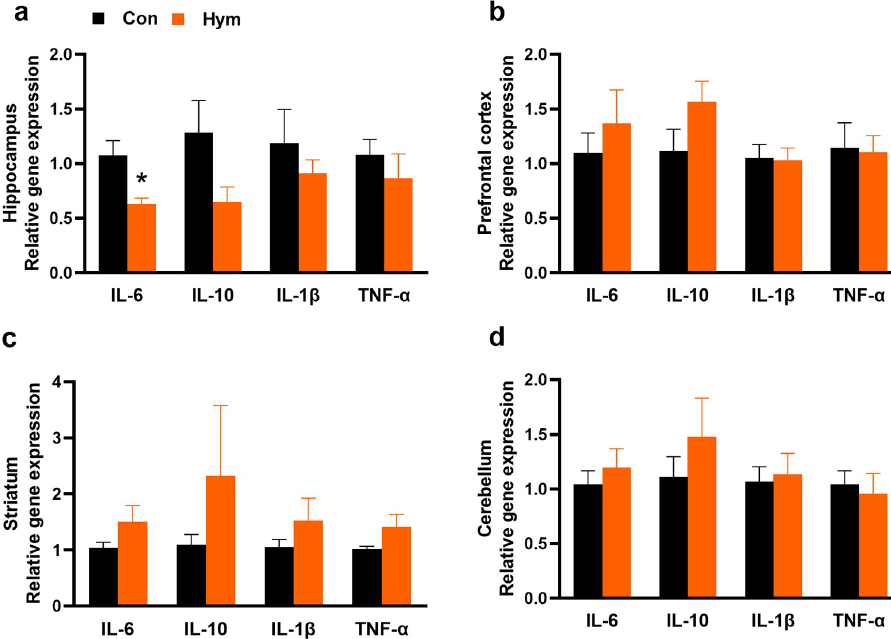
Fig 6. Real-time quantitative RT-PCR analyses for control rats (Con, n = 8) and rats infected with H . diminuta (Hym, n = 7). Gene expression levels represent the mRNA expression for IL-6, IL-10, IL-1 β and TNF- α in the hippocampus (a), prefrontal cortex (b), striatum (c) and the cerebellum (d) relative to the control. Values represent the means ± SEM for two experimental groups. � Hym vs Control, p < 0.05 (Newman-Keuls test).